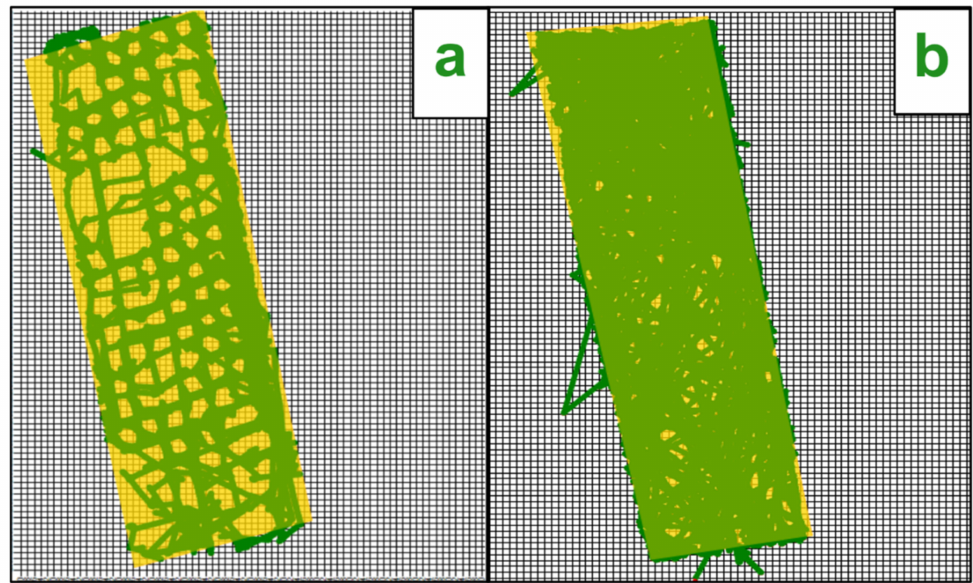
Figure 9. ( a ) Custom-built software showing the working path of the autonomous mower (green lines) managing a vegetable plot on 29 July 2020 after four hours of mowing; ( b ) Custom-built software showing the working path of the autonomous mower (green lines) managing an obstacle-free plot on 7 June 2021 after four hours of mowing.